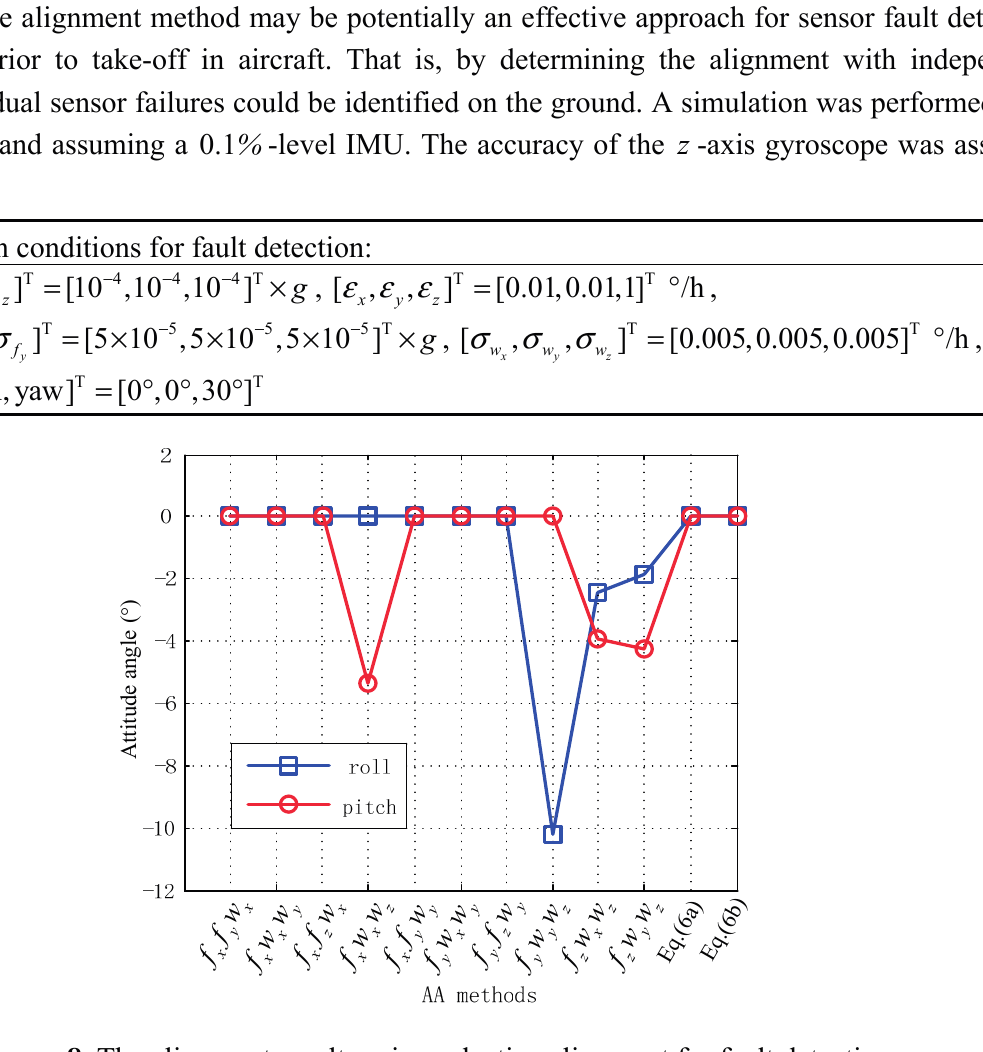
Figure 8. The alignment results using selective alignment for fault